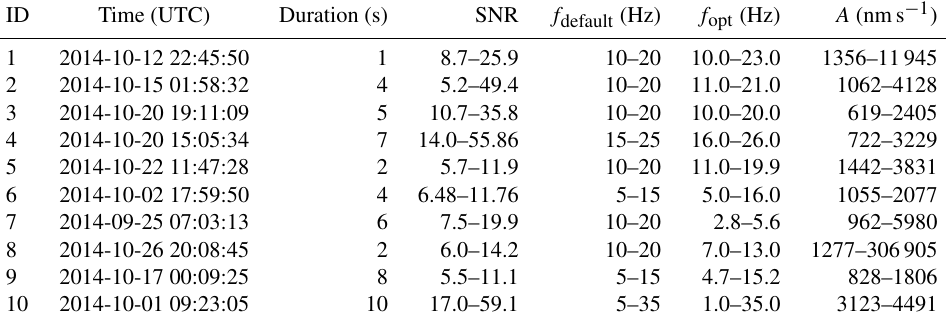
Table 2. Rockfall events detected by seismic monitoring. IDs correspond to those in Table 1. Duration as estimated from signal wave form interpretation (not including subsequent talus slope activity). SNR denotes range of signal-to-noise ratios among all recording stations. f default describes the default frequency range for location, and f opt denotes the frequency range after optimisation. A is the amplitude range among the